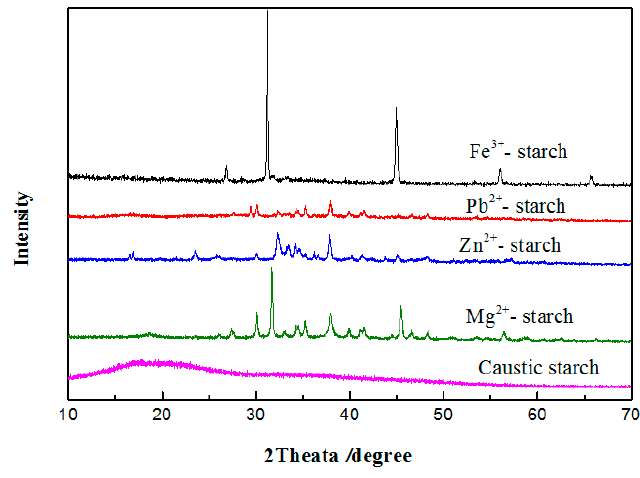
Figure 1. XRD spectra of the metallic-starch complex (MSC) and caustic starch.